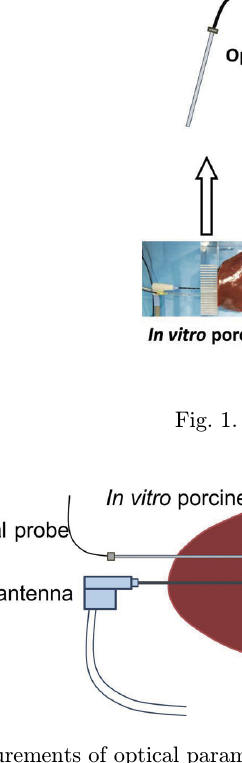
Fig. 2. Measurements of optical parameters and temperature during ablation.